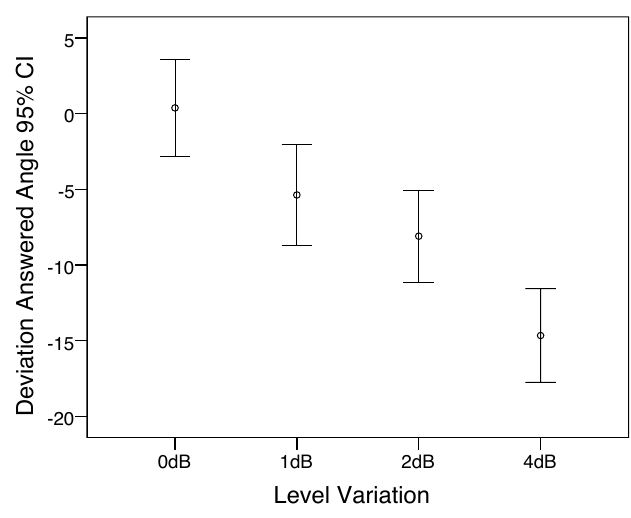
Figure 5. Average deviation of the answered angles (degrees) versus level variation (dB), considering only the angles 0 ◦ and 65 ◦ .